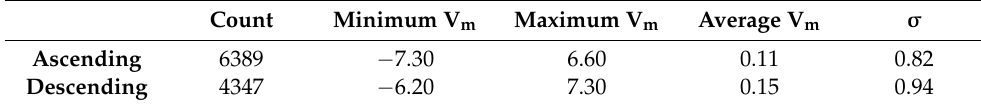
Table 1. Statistics of the mean velocity V m (mm/y) of the selected area of Eixample .